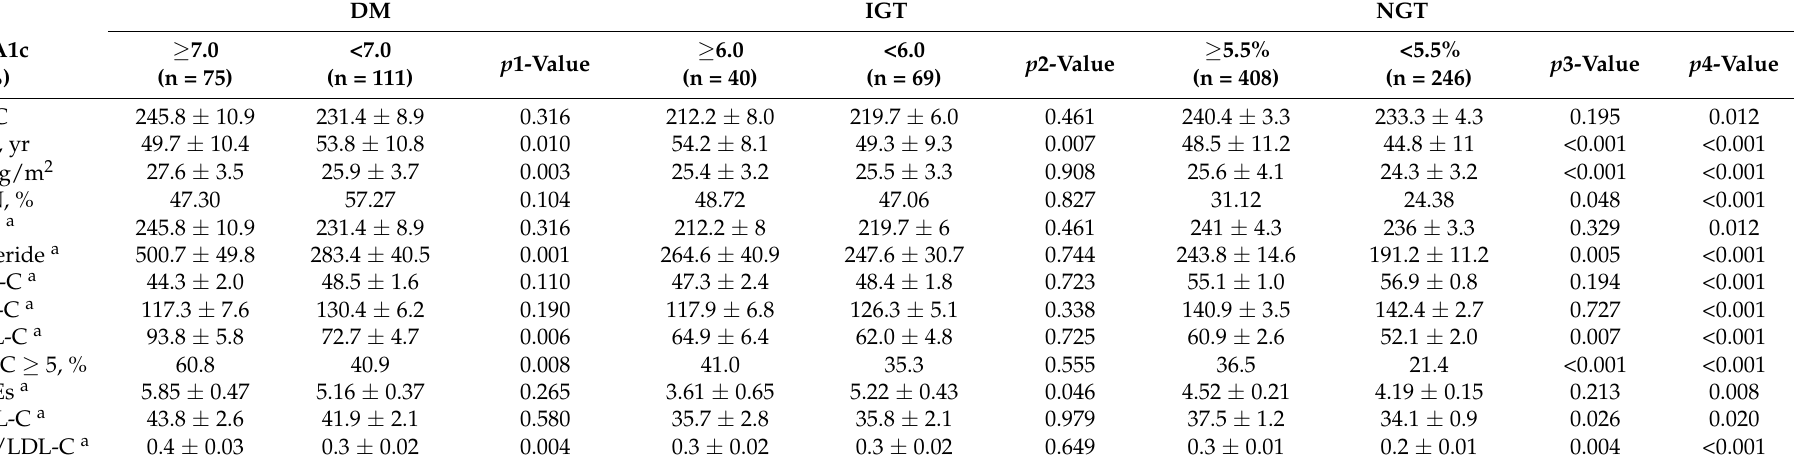
Table 4. Cardiovascular characteristics of clinical subjects after OGTT stratified by glycation hemoglobin levels, with a cutoff point of 5.5% in the NGT group. DM IGT